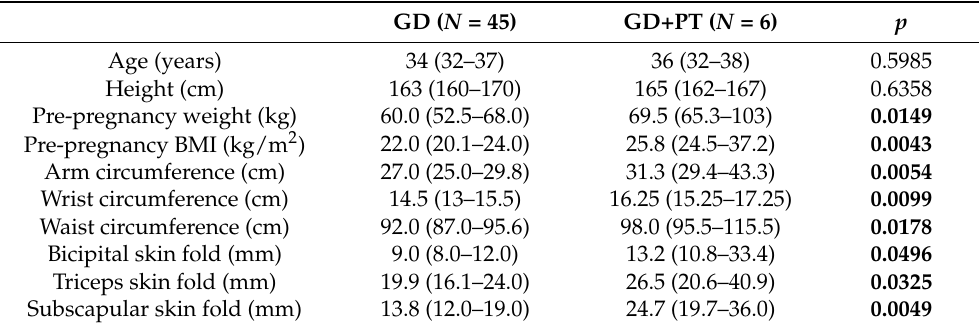
Table 2. Age and anthropometric parameters at T0 of subjects with GD who required therapy to normalize blood glucose levels (GD+PT) and subjects who did not require pharmacological intervention (GD).